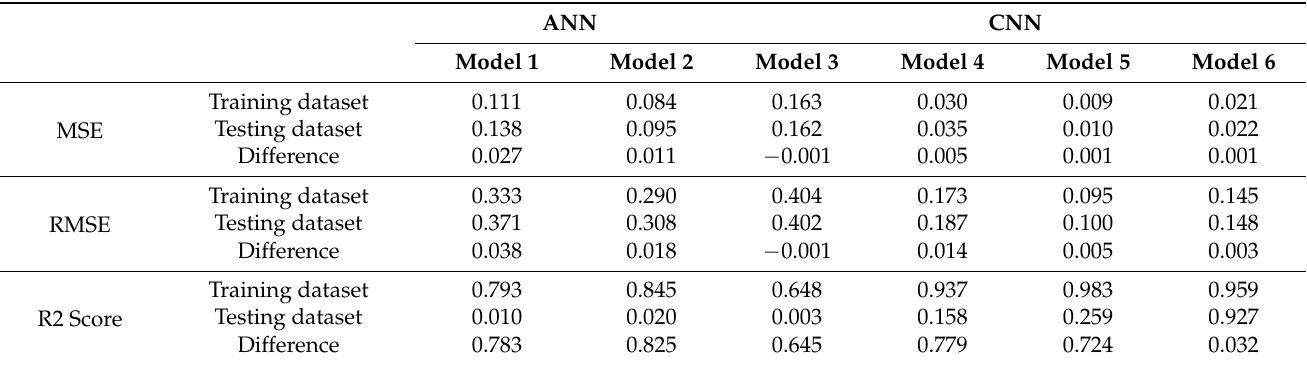
Table 8. Performance of Group A models at 2500